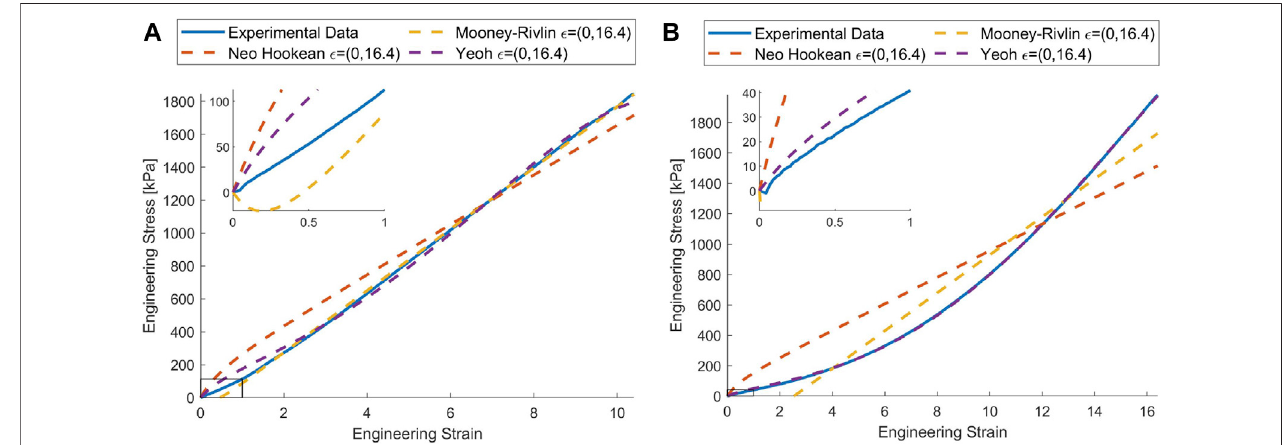
FIGURE 1 | When the material models are trained using the entire set of tensile data, the error from the model in the region of interest may be considerable. In this case, we highlight this effect by zooming into a smaller strain range (100%), for (A) Dragon Skin ™ 10 MEDIUM and (B) Eco fl ex ™ 00-50 where there is a signi fi cant variance between the models and experimental data. Ogden model excluded for readability [Data and the Code provided by Marechal et al. (2020)].